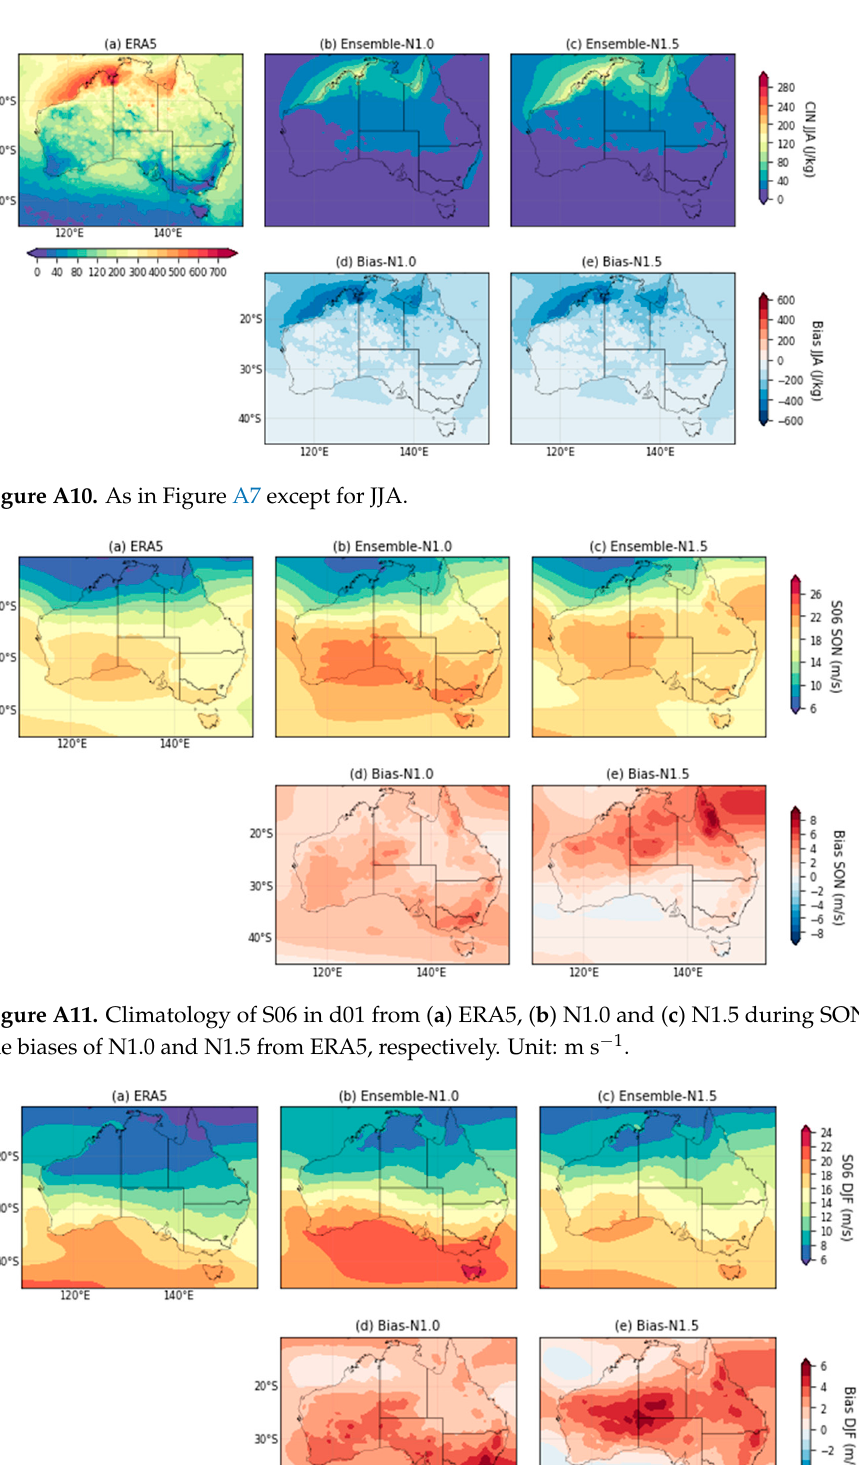
Figure A13. As in Figure A11 except for MAM.